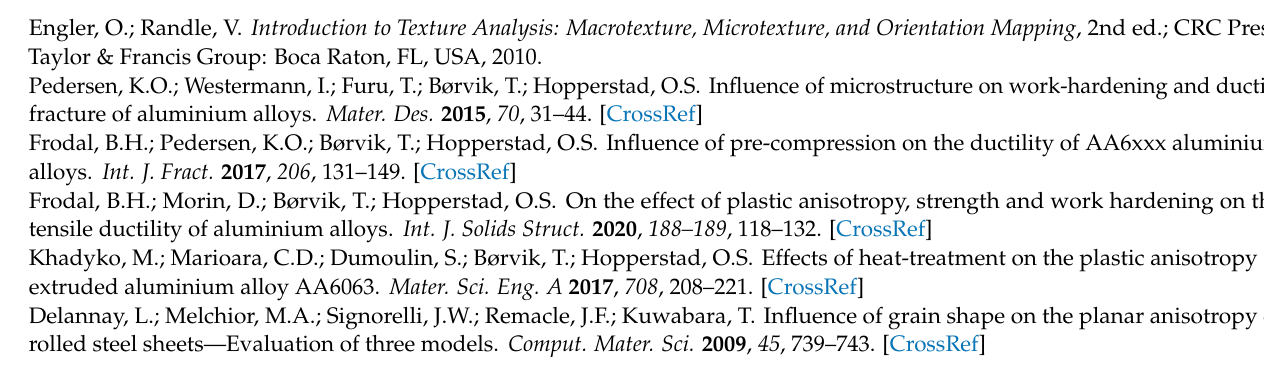
Figure S3: Fracture surfaces of representative tension tests in the 0 ◦ , 45 ◦ and 90 ◦ directions of the R2.0 specimen for alloy AA6061, Figure S4: Fracture surfaces of representative tension tests in the 0 ◦ , 45 ◦ and 90 ◦ directions of the R2.0 specimen for alloy AA6063, Figure S5: Fracture surfaces of representative tension tests in the 0 ◦ , 45 ◦ and 90 ◦ directions of the R2.0 specimen for alloy AA6110, Table S1: Particle size measurements for the extruded materials, Table S2: Characteristic stress and strain values from the tension tests of alloy AA6061 given at 0.2% plastic strain, necking and failure, in addition to the strain at fracture calculated from post-experimental measurements of the fractured cross-section area, Table S3: Characteristic stress and strain values from the tension tests of alloy AA6063 given at 0.2% plastic strain, necking and failure, in addition to the strain at fracture calculated from post-experimental measurements of the fractured cross-section area, Table S4: Characteristic stress and strain values from the tension tests of alloy AA6110 given at 0.2% plastic strain, necking and failure, in addition to the strain at fracture calculated from post-experimental measurements of the fractured cross-section